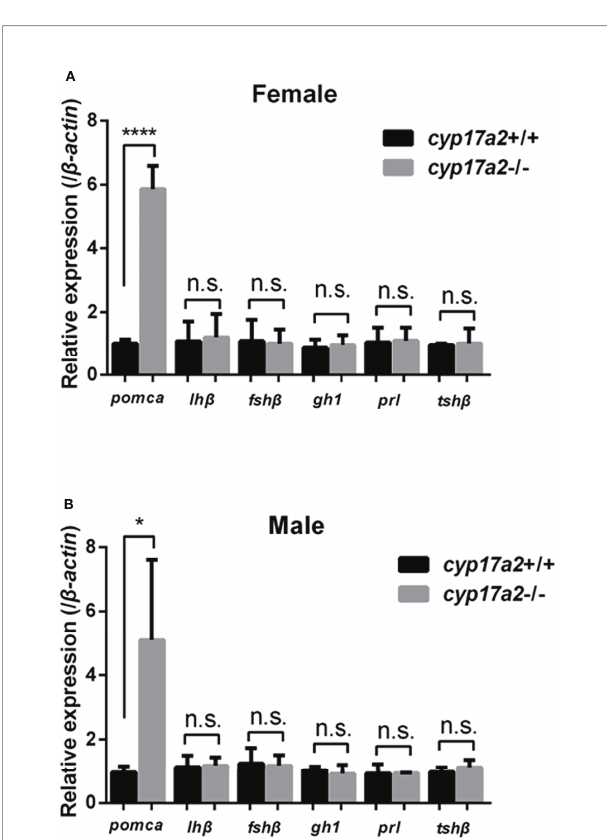
FIGURE 7 | Expression pro fi les of pituitary hormones. Expressions of pomca , lh b , fsh b , gh1 , prl and tsh b in cyp17a2 +/+ and cyp17a2 -/- zebra fi sh at 3 mpf were analyzed with qPCR. All mRNA levels were calculated as the fold expression relative to the housekeeping gene b -actin . (A) Control females and cyp17a2 -/- females. (B) Control males and cyp17a2 -/- males. n.s., no signi fi cant difference. * P < 0.05. **** P <